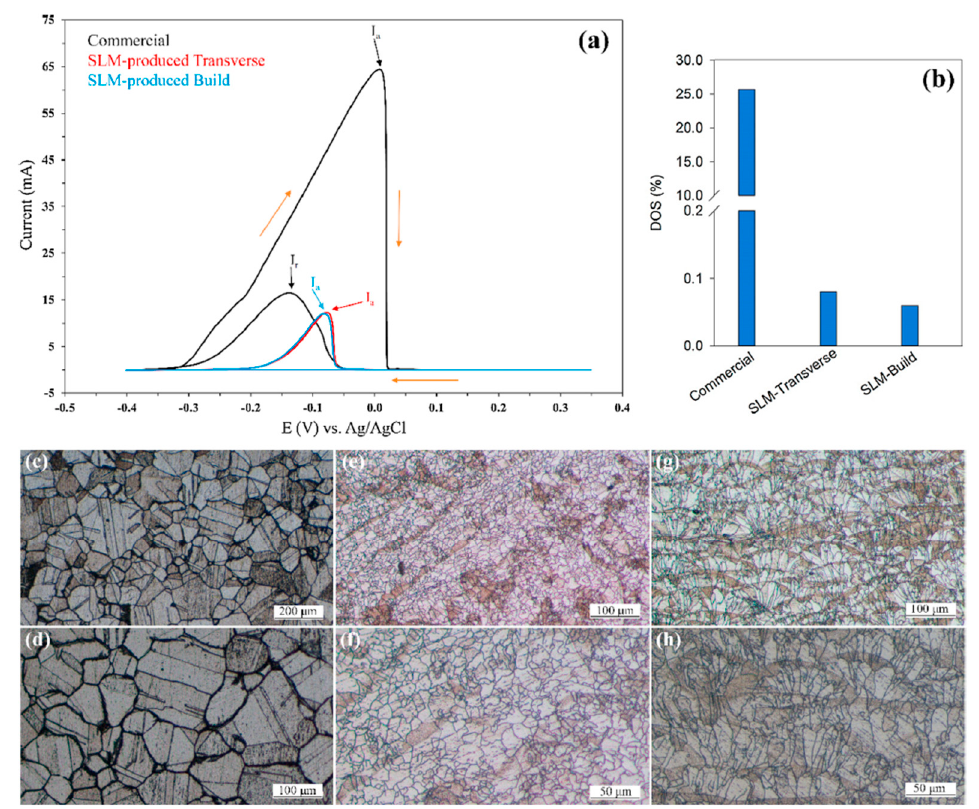
Figure 4. ( a ) DL-EPR curves for the commercial and the SLM-produced 316L samples; ( b ) the DOS values measured from the peak current densities of the forward and reverse scans in the DL-EPR curves; ( c , d ) the optical surface images after DL-EPR tests for the commercial 316L SS; ( e , f ) the SLM-produced 316L SS at transverse, and ( g , h ) at build [39].